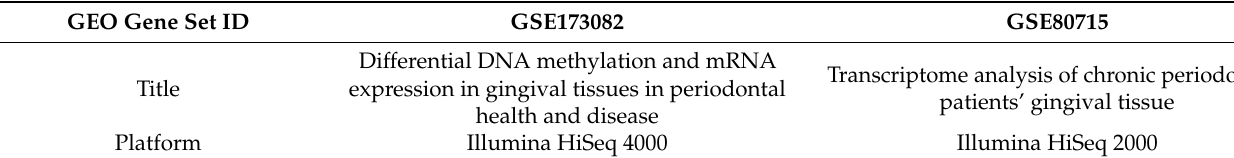
Table 1. Summary of two individual public datasets of